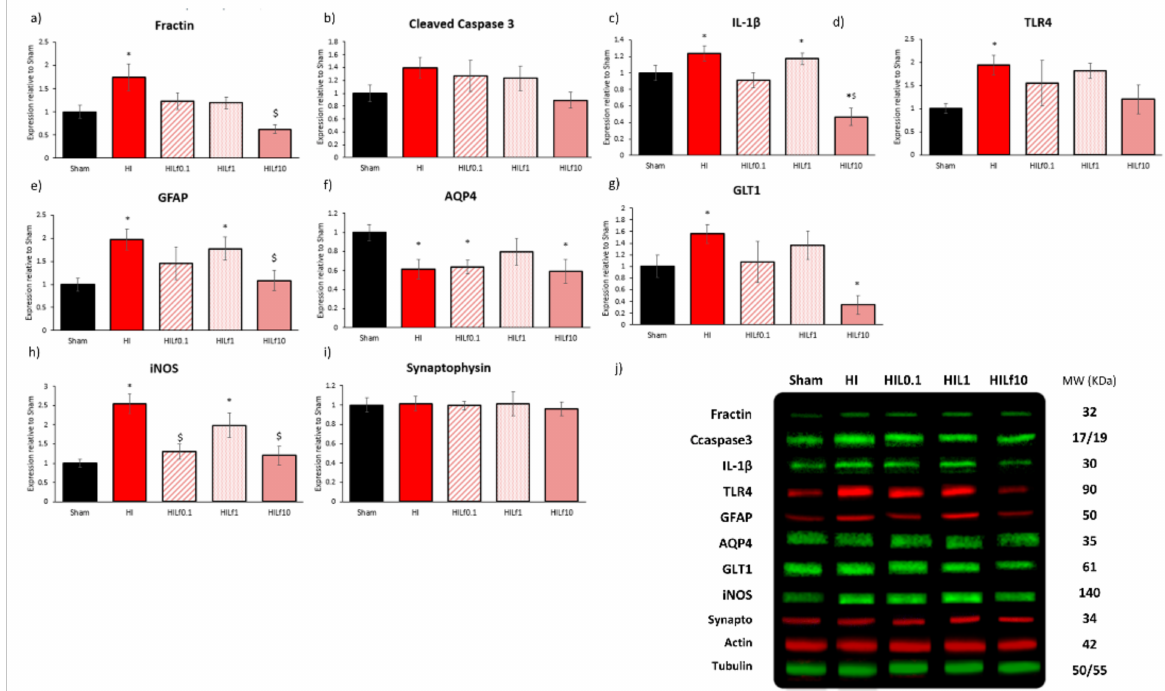
Figure 3. Effects of Lf and HI on protein expression in the right cortex at P4 (24 h) after injury. Dams were fed control diet (Sham and HI), Lf 0.1 (HILf0.1), 1 (HILf1), or 10 (HILf10) g/kg lactoferrin. All proteins were quantified by densitometry, and then normalised to actin or tubulin and expressed as a value (ODI) relative to the Sham group for: fractin ( a ), cleaved caspase 3 ( b ), IL-1 β ( c ), TLR4 ( d ), GFAP ( e ), AQP4 ( f ), GLT1 ( g ), iNOS ( h ), and synaptophysin ( i ). Representative bands of proteins with the respective molecular weight (mw) in KDa ( j ). All values are presented as the mean ± SEM, n = 4–6 animals per group. * HI vs. SH, $ difference between HILf groups. Differences were determined by one-way ANOVA and considered significant when p <